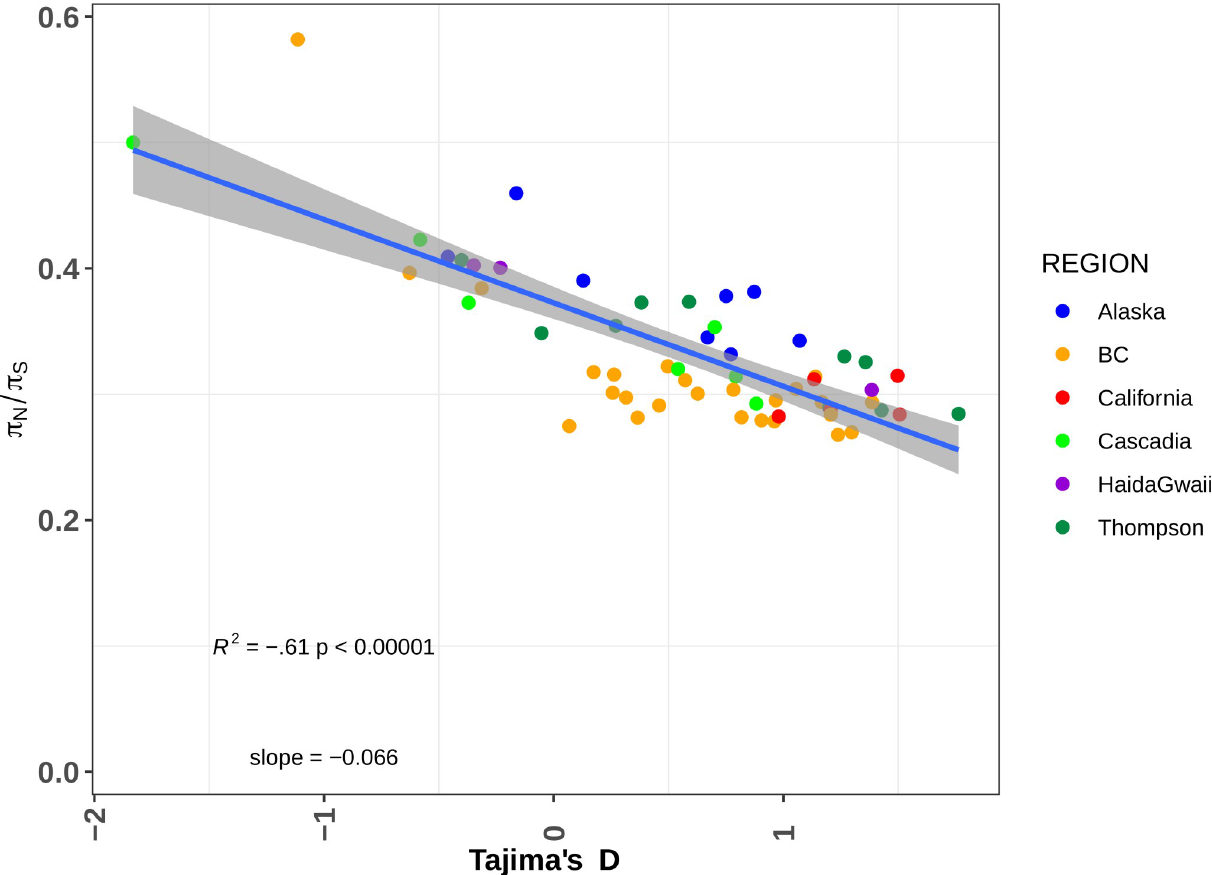
Fig 5. Recent demographic history shaped the deleterious mutation load: Correlation between Tajima’s D and the deleterious load ( π N / π S ). R 2 = coefficient of determination of the linear model.